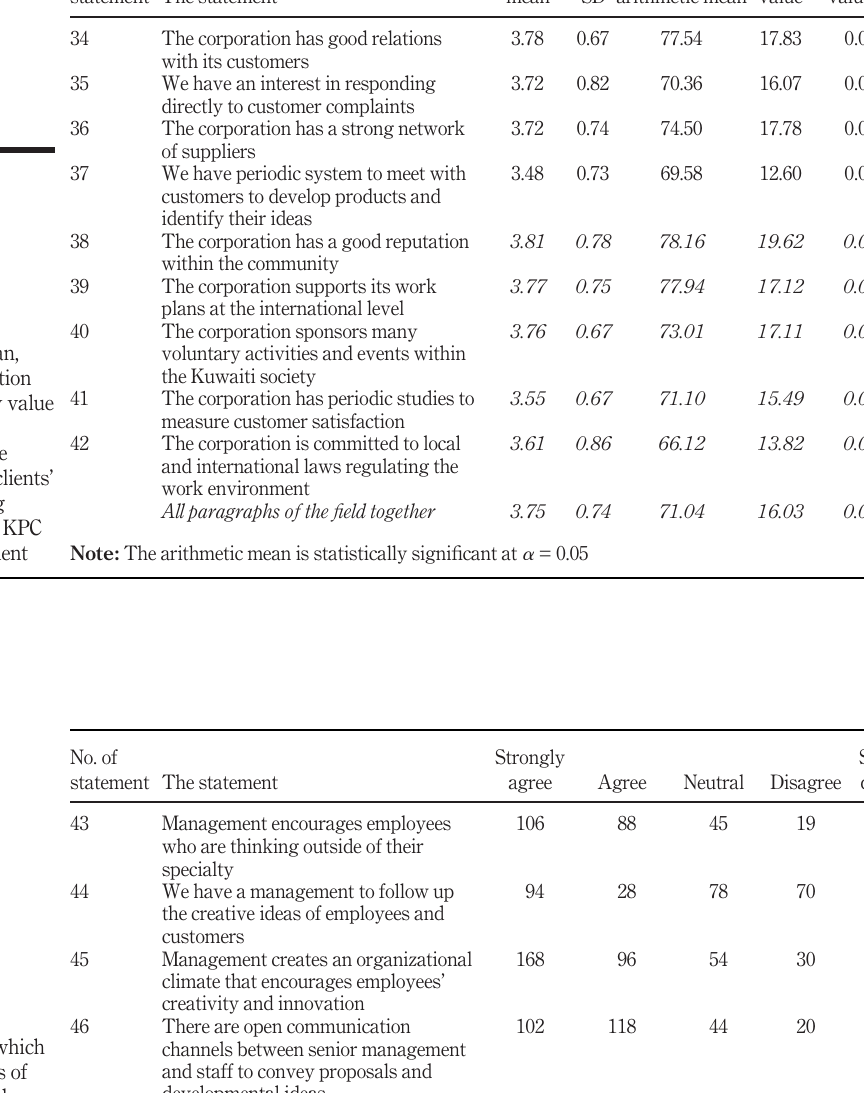
Table A8. Frequency by which the respondents of the study sample practice the organizational innovation in KPC work